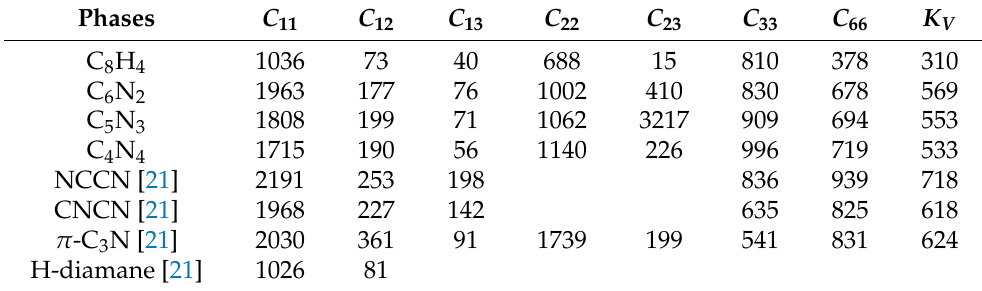
Table 3. The elastic constants and Voigt bulk modulus ( K V ) of four phases of W-diamanes are reported in GPa unit by comparing with those of other 2D sp 3 carbons and carbon